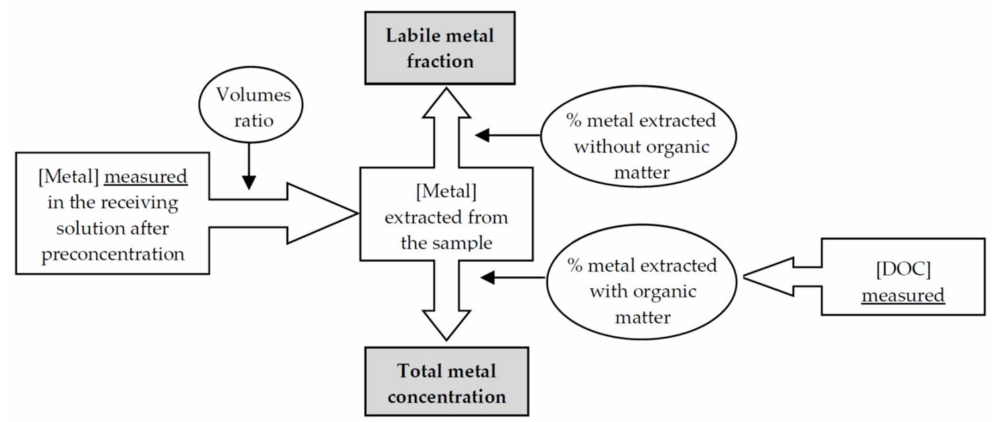
Figure 6. Schematic procedure for nickel speciation in water